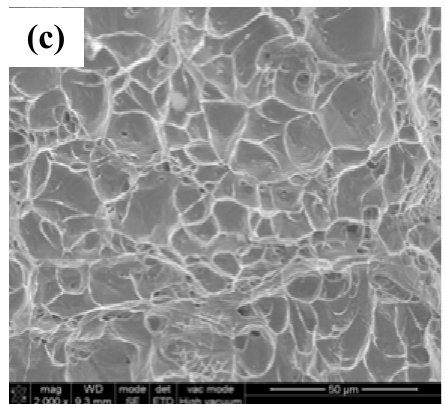
Figure 4. SEM fracture surfaces of the ULK-TIG welded joint after Charpy impact tests. ( a ) BM, ( b ) underwater WM and ( c ) onshore WM [13] .